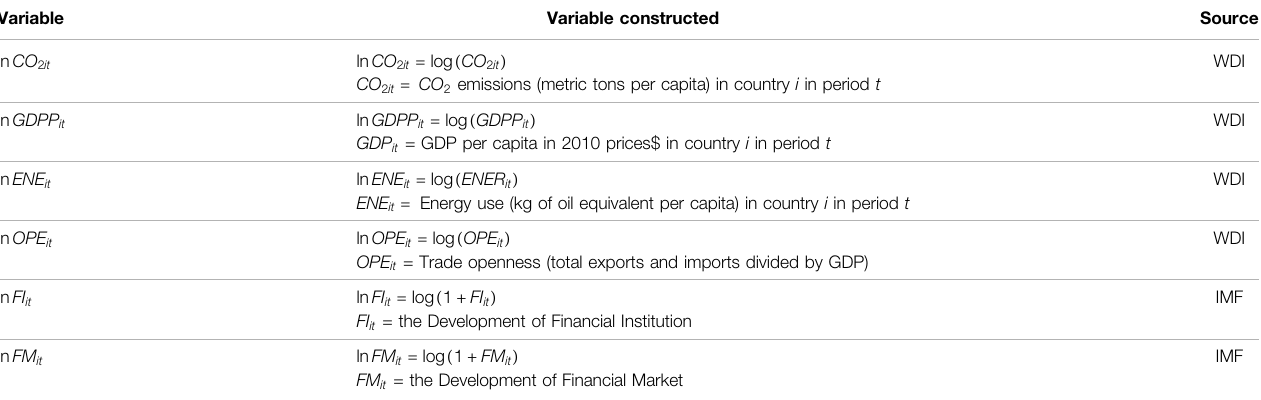
TABLE 1 | Variable de fi nition. Variable Variable constructed